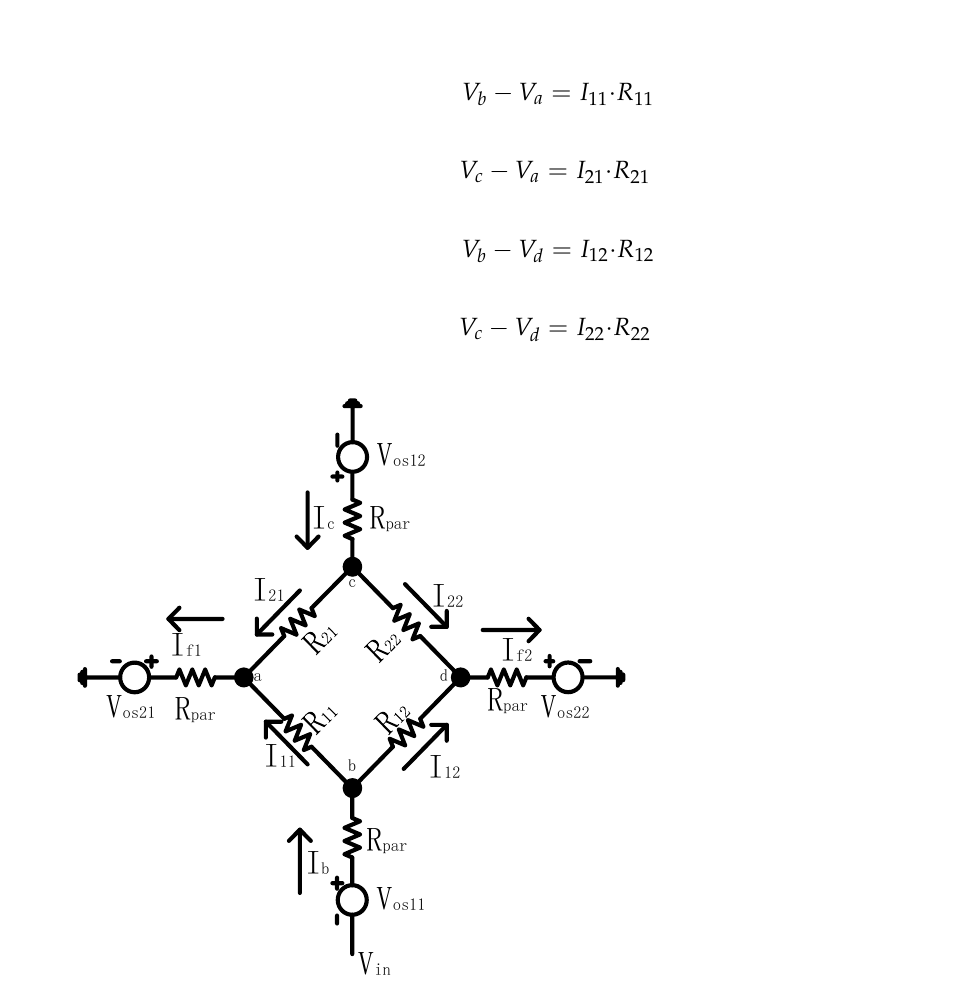
Figure A4. Array network extracted and analyzed with Kirchhoff’ s law .